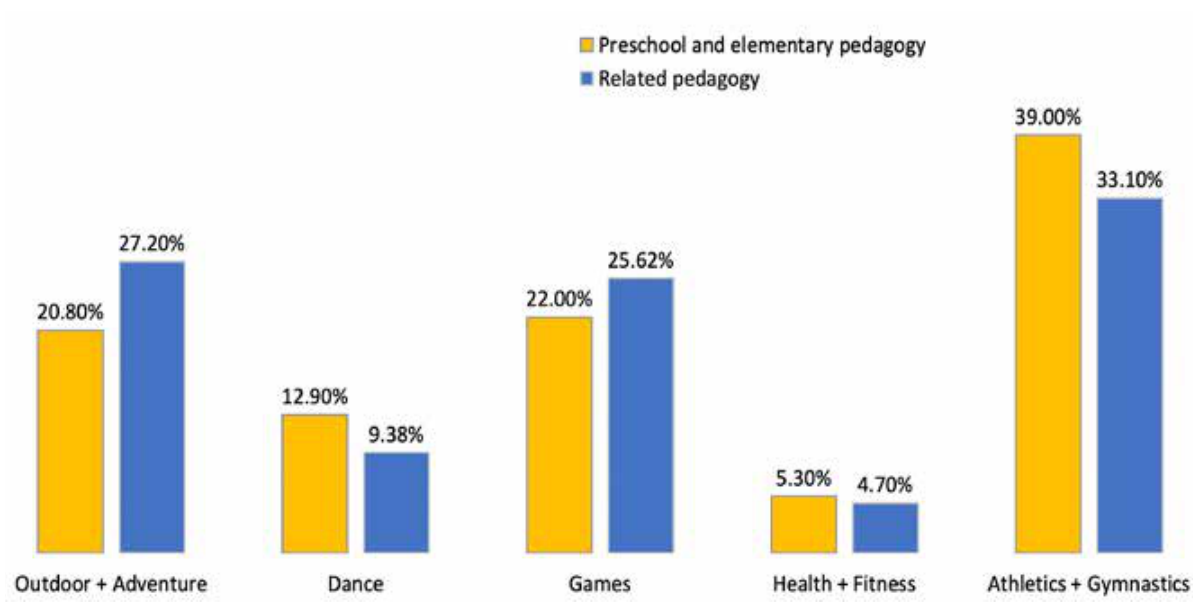
Figure 4. Undemanding teaching activity in primary physical education